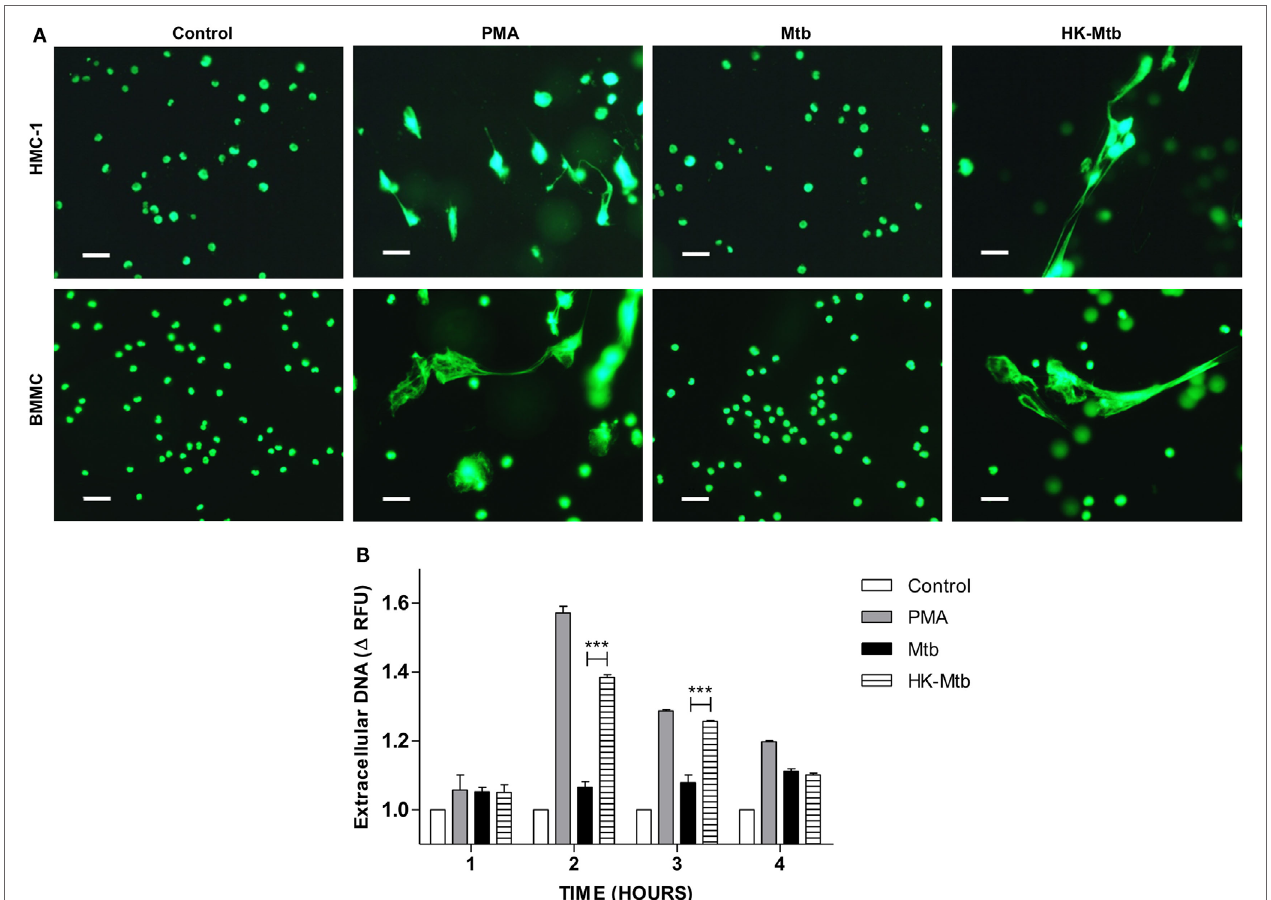
FigUre 1 | Mast cells release DNA in response to heat-killed but not live Mycobacterium tuberculosis (Mtb). (a) Representative micrographs of HMC-1 cells or bone marrow-derived mast cells (BMMC) unstimulated (control) or stimulated during 2 h with PMA, live Mtb, or heat-killed Mtb (HK-Mtb) at a MOI of 10. DNA was visualized after staining with SYTOX-Green. Scale bar 20 µm (magnification 400 × ). (B) Released DNA was quantified in unstimulated HMC-1 cells (control) or stimulated at indicated times with PMA, live Mtb, or HK-Mtb at a MOI of 10. Released DNA was partially digested with DNase I and quantified in supernatants with SYTOX Green I in a fluorometer. The graph represents the change in fluorescence ± SD of stimulated cells compared to control. *** p < 0.001 as